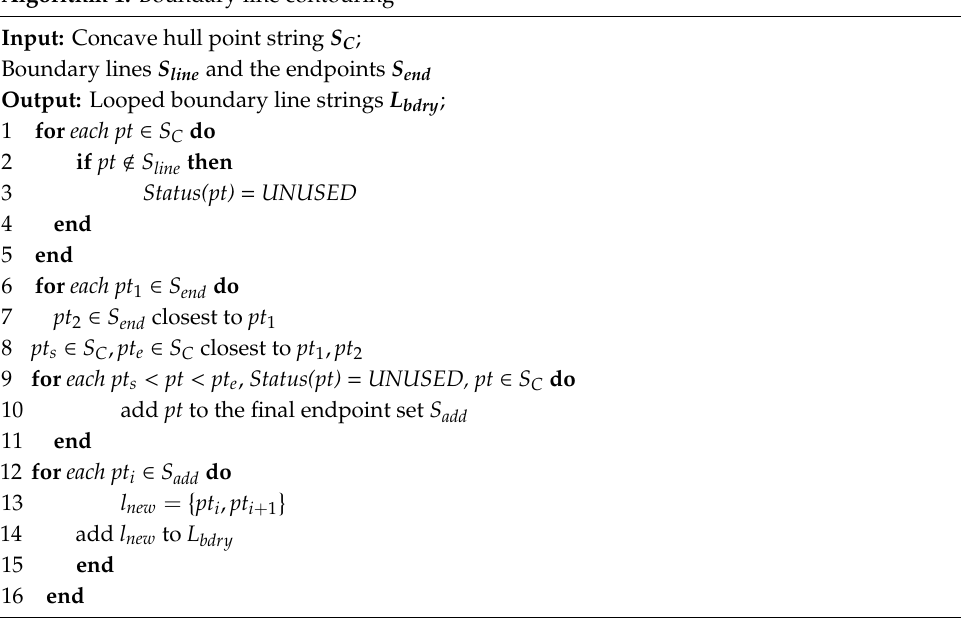
Figure 4. Boundary points estimation in k nearest neighbors (k=16). ( a ) The red point is identified as a boundary point. ( b ) Points are down-sampled to 1000 points (green) with 164 boundary points (red) detected. ( c ) The original 77835 points (green) with 1448 boundary points (red) detected. Algorithm 1. Bounda ry line contouring